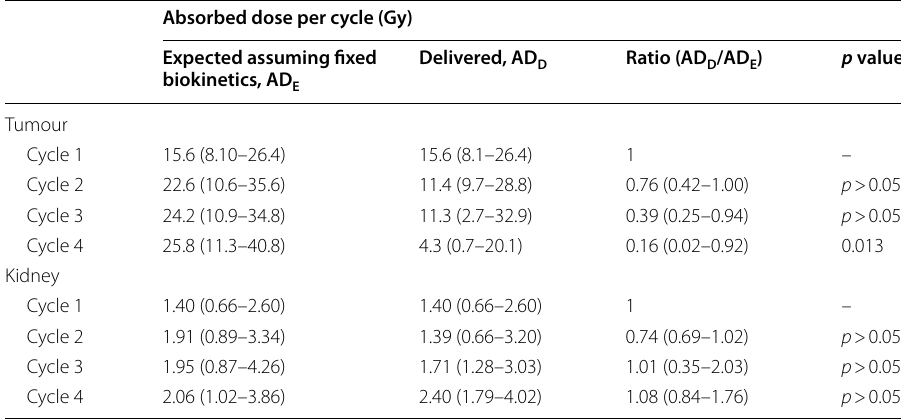
6) for the tumour and kidney =